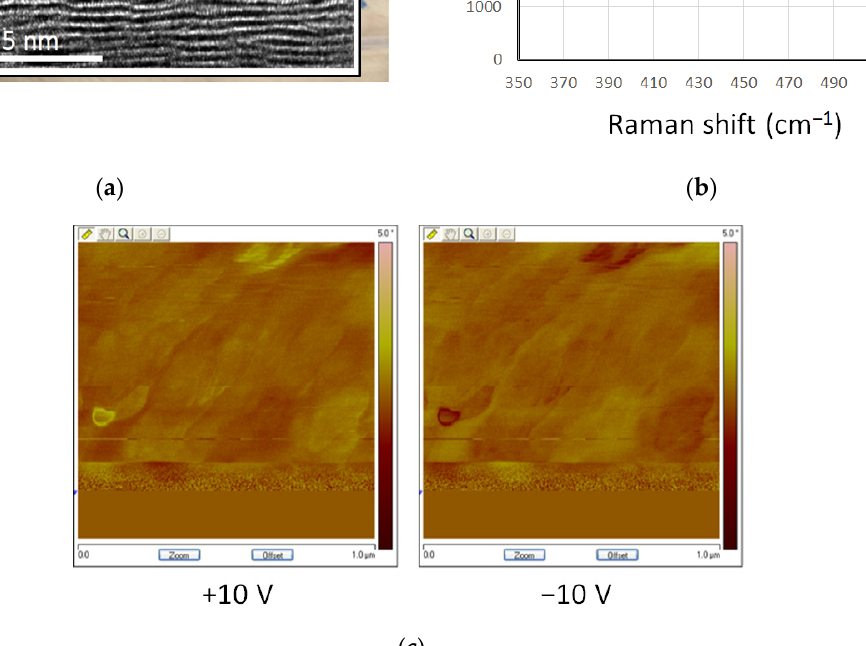
Figure 2. EH2N testing ( a ) EH2N grown by CVD ( b ) Raman characterization data of EH2N grown on a SiO 2 /Si substrate ( c ) PFM measurements of EH2N. The observed phase shift between the two different voltage polarities indicate that the EH2N thin film expands and contracts with the electric field direction (i.e., piezoelectric).